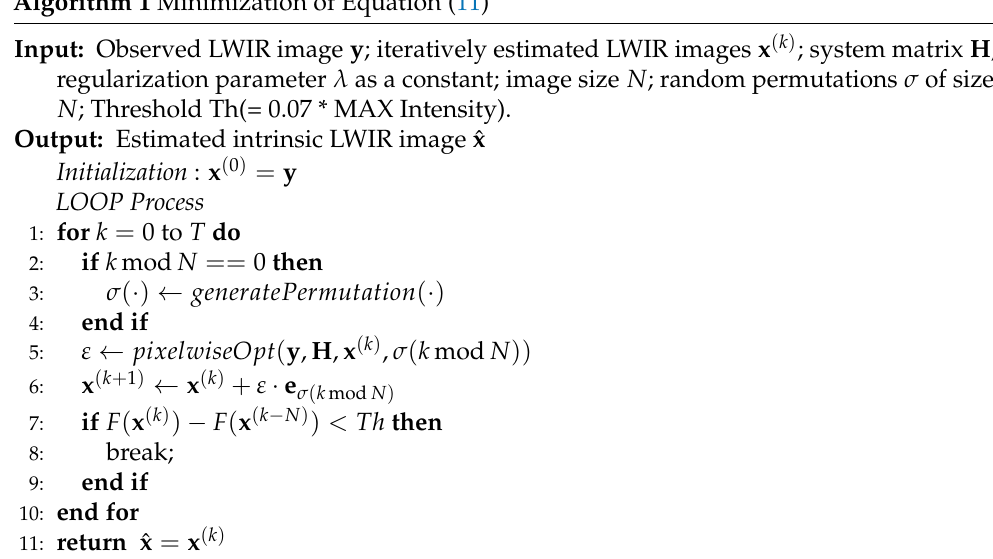
Figure 7. Example of a one-dimensional subproblem represented in Equation (18). A single vari- able subproblem (blue line) derived from the TV-regularized cost function of Equation (11) can be decomposed into two parts: the part derived from the data fidelity term (black line), and from the regularization term (red line). The solution of the subproblem lies between the critical points of data fidelity and the regularization functions. Nine points marked by (cid:101) l , { l | 1,2, · · · ,9 } are investigated to find the minimum value of f τ ( ε ) . All functions are plotted on the same scale (˜ λ = 1) for visualization. Algorithm 1 Minimization of Equation